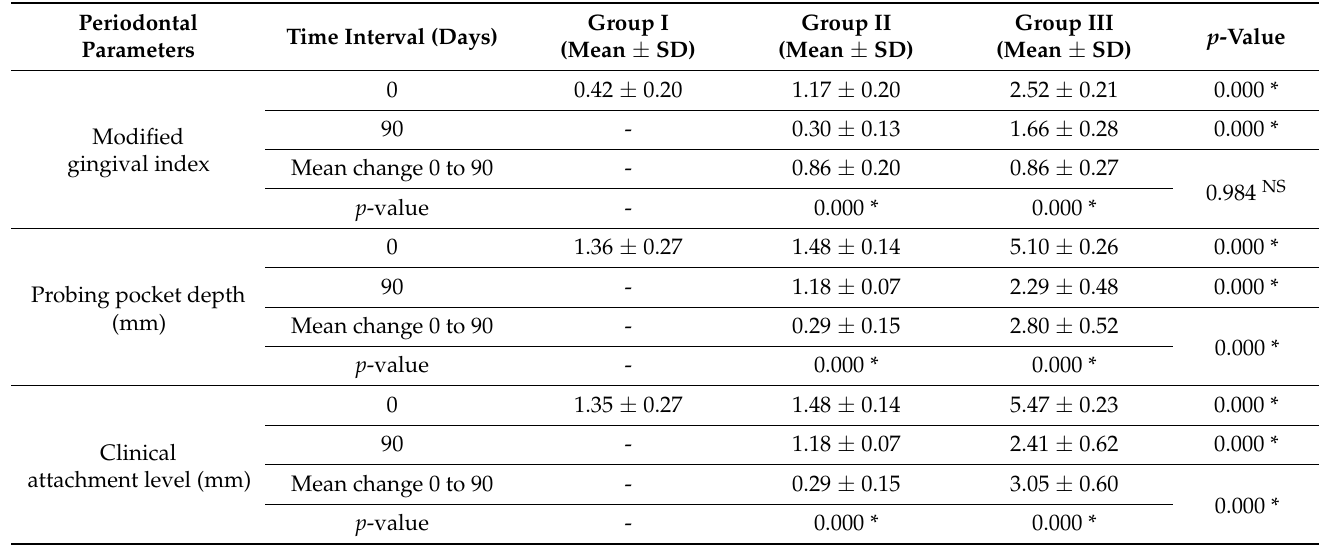
Table 1. Comparison of standard deviation, mean, and significant differences for periodontal param- eters (MGI, PPD, CAL) within and between groups at different time intervals.